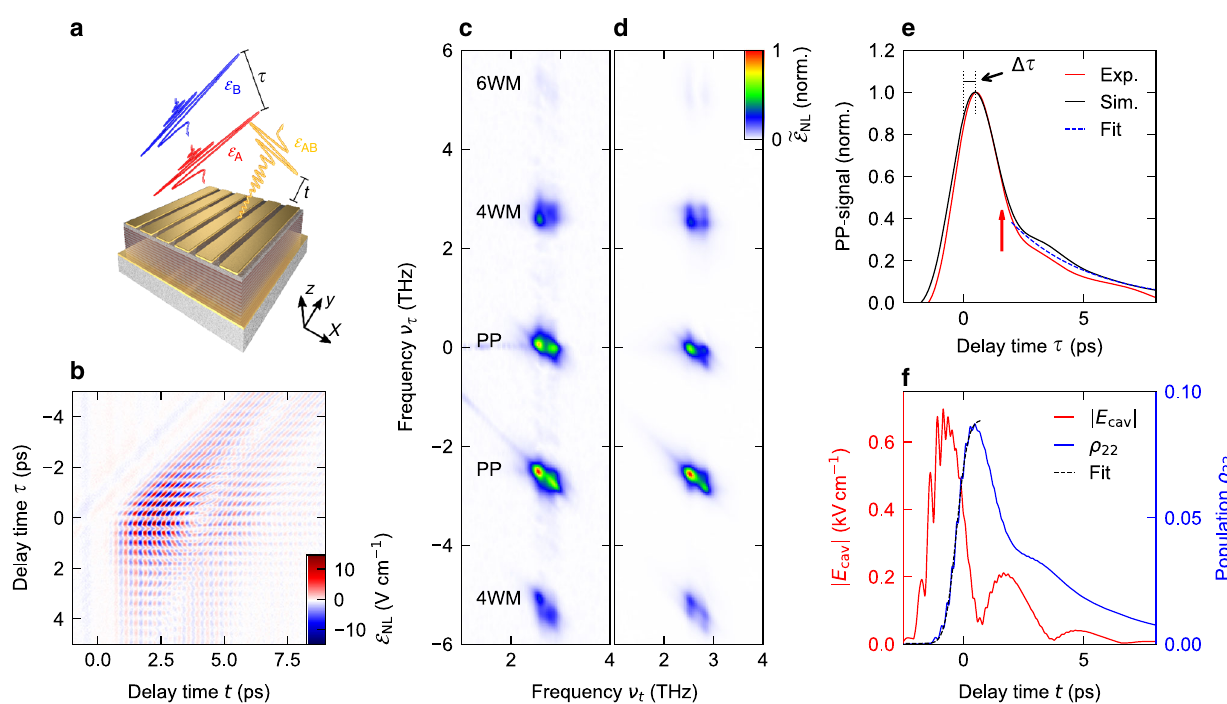
Fig. 3 Time-resolved nonlinear dynamics of the polaritonic saturable absorber. a Experimental principle of two-dimensional THz spectroscopy. The two THz pulses (red and blue waveforms, delayed by a delay time τ ) prepare and probe the nonlinear dynamics of the saturable absorber. The emitted THz waveform E AB is sampled electro-optically as a function of the delay time t . b Colour plot of the emitted nonlinear electric fi eld, E NL = E AB − E A − E B as a function of the electro-optic delay time t and τ at a peak THz intensity of I = 7 W cm − 2 . c Two-dimensional Fourier transform of the electric fi eld in b . d Simulated 2D spectra, calculated from a semiclassical theory. e Experimental (red curve) and simulated pump – probe signal (black curve) as a function of the delay time τ for a fi xed electro-optic delay time of t = 1.66 ps. The maxima are offset from time zero by Δ τ = 0.5ps. Dashed blue curve: exponential decay with a characteristic time of 3.3ps, as a guide to the eye. f Calculated dynamics of the cavity fi eld amplitude (| E cav |, red curve), and the population of the second subband ( ρ 22 , blue curve). Black dashed curve, fi t of ρ 22 by a time-integral of a Gaussian envelope function, demonstrating a rise time of ∼ 900 ps.